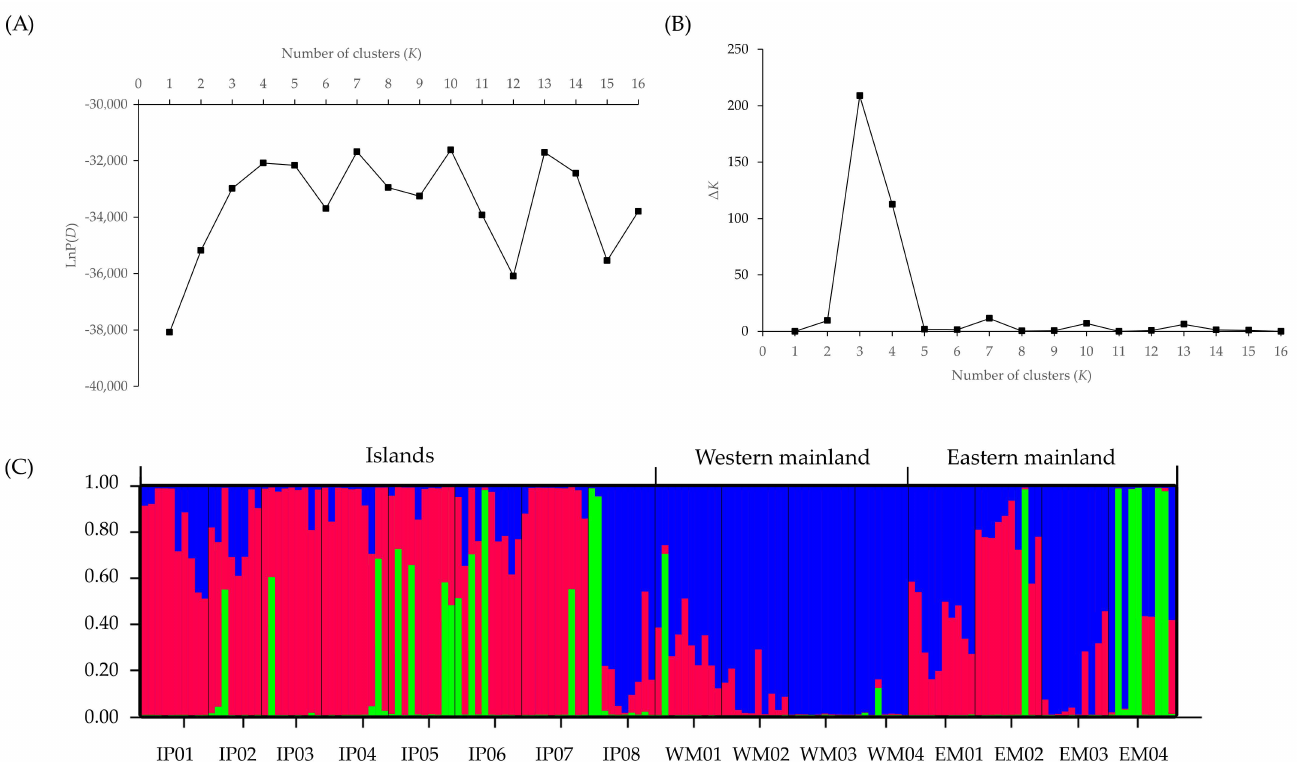
Figure 1. STRUCTURE analysis of 155 individuals (16 populations) of Hedyotis chrysotricha from the Thousand-Island Lake (TIL) region, based on RAD-Seq-derived single nucleotide polymorphism (SNP) data. ( A ) Plots of the mean posterior probability [LnP( D )] values of each K and ( B ) the corresponding ∆ K statistics. ( C ) Histogram of the STRUCTURE analysis for the model with K = 3 (showing the highest ∆ K ). A vertical bar represents a single individual, and each color corresponds to a suggested cluster (Cluster I: dark blue; Cluster II: red; Cluster III: green). The x -axis corresponds to population codes. The y -axis presents the estimated membership coefficient ( Q ) for each individual in the three